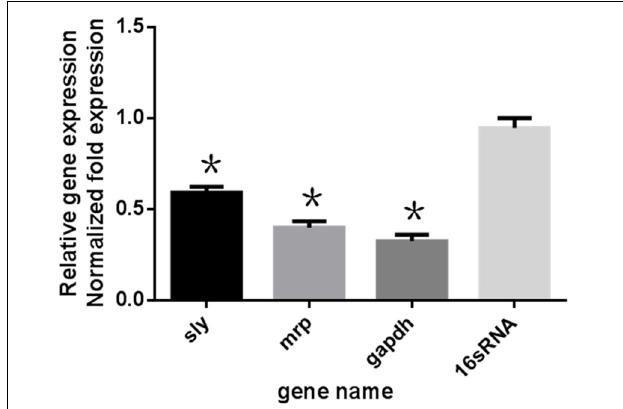
FIGURE 5 | Effect of 1/2MIC of aqueous extracts of Rhizoma Coptidis on mRNA decreased expression of genes in S. suis ATCC700794. Data are expressed as means ± standard deviations. The expression was normalized to 16S rRNA. Controls refer to the absence of aqueous extracts of Rhizoma Coptidis . Significantly different ( ∗ p < 0.05) compared to untreated control bacteria.